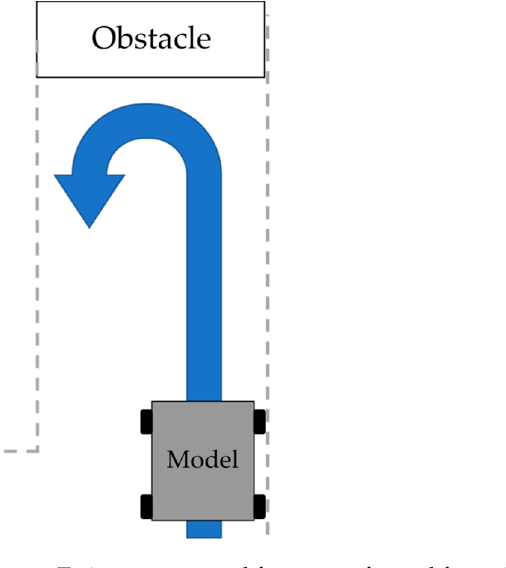
Figure 6. Trajectory assumed for test performed for training data gathering. The output of the structure was a two-row vector of forcing speeds for left and right wheels. At this point in the work, implementation of the M ulti L ayer P erceptron (MLP) with linear activation functions was proposed. As in the previous section, the adaptation of internal coefficients was performed using the Levenberg–Marquardt algorithm. In Figure 7, both target control signals and neural planner response are presented. It is worth indicating that the transients of reference speeds of the wheels are similar for both types of control loop. The response of the neural path planner is smoother as in case with no quantized values. Such a ‘soft’ reference signal is easier to reproduce and may lead to smaller overshoots obtained by the speed controller. As it can be seen in Figure 7, an insignificant difference in desired speeds of the left and the right wheels was observed while the neural controller was applied. During the performed test, it did not affect the desired path. The most visible disadvantage of the neural structure was the delay that was observed. The reaction was delayed by one sample. Nevertheless, it is possible to apply the designed neural planner in the control structures of vehicles where an automatic control is the most important observed feature and may be neglected. Moreover, after additional pre-processing (shift of the output samples relative to input values) of the measured training data, the mentioned delay can be eliminated.